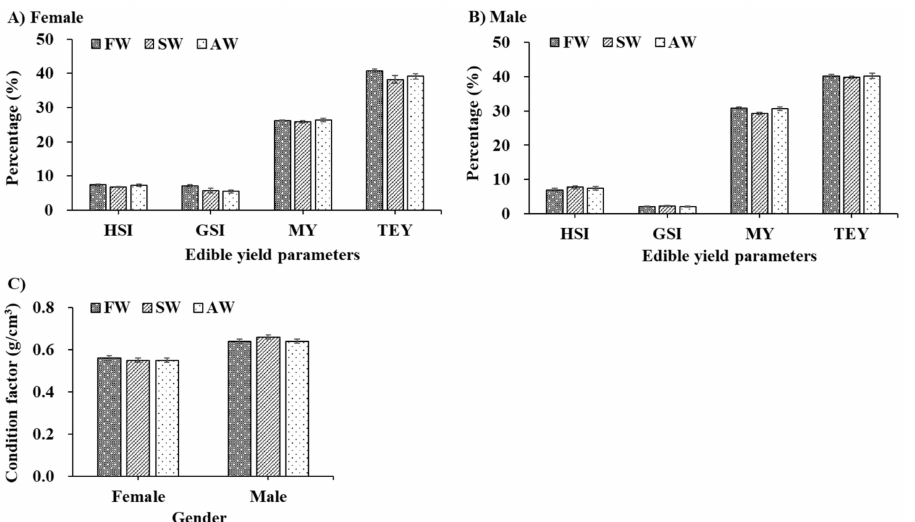
Figure 1. The edible yield (% body weight, ( A , B )) and condition factor (%, ( C )) of adult Eriocheir sinensis from different culture environments. The data are presented as mean ± standard error (SE) (n = 20). FW, freshwater; SW, saline water; AW, Alkaline water; HSI, hepatosomatic index; GSI, gonadosomatic index; MY, meat yield; TEY, total edible yield.